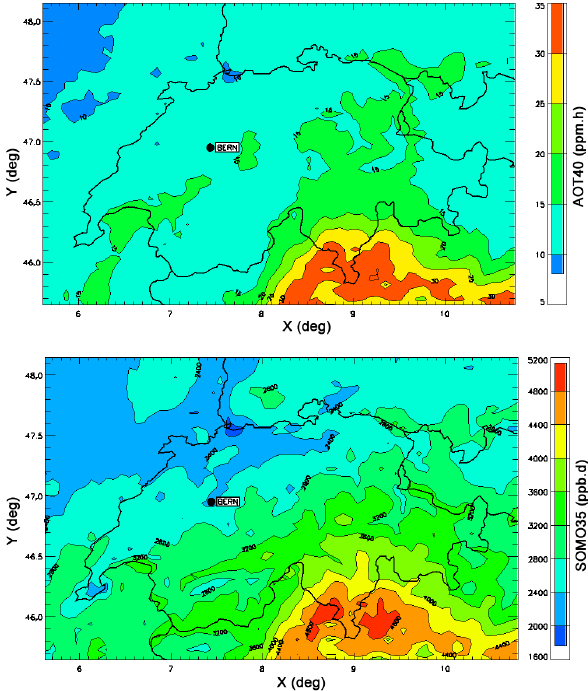
Figure 11. Modelled AOT40 (ppmh) (upper panel) and SOMO35 (ppbd) (lower panel) over the Swiss domain for the reference year